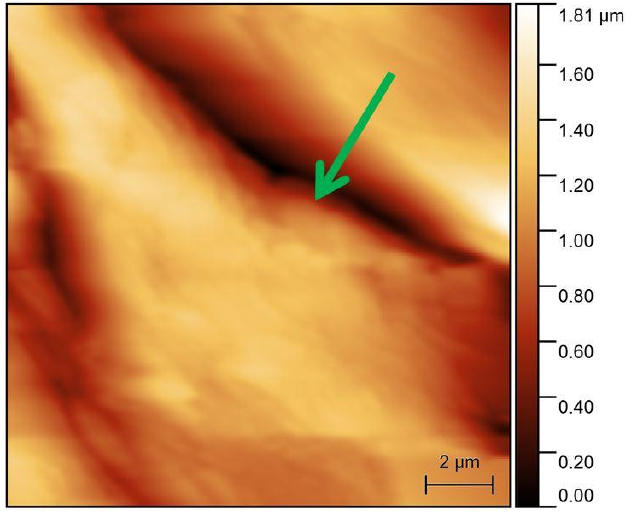
Figure 8. AFM pictures of PEEK surface after modification. Arrow points onto the same surface detail as in the previous picture.